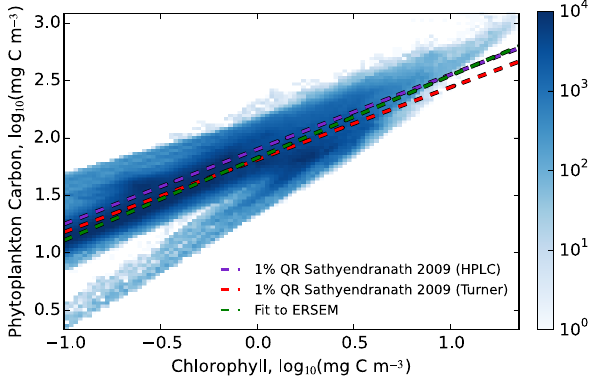
Figure 5. The ratio of phytoplankton carbon to total chlorophyll. The model data are shown as the logarithmically scaled two- dimensional data histogram distribution in blue scale. The dashed lines show the fit to data, a fit of the model to Eq. (7), and the re- sults of the two 1% quantile regression from Sathyendranath et al. (2009).